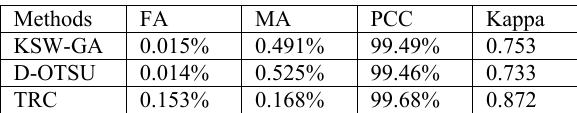
Table 1. Comparison of change detection results on Bern.